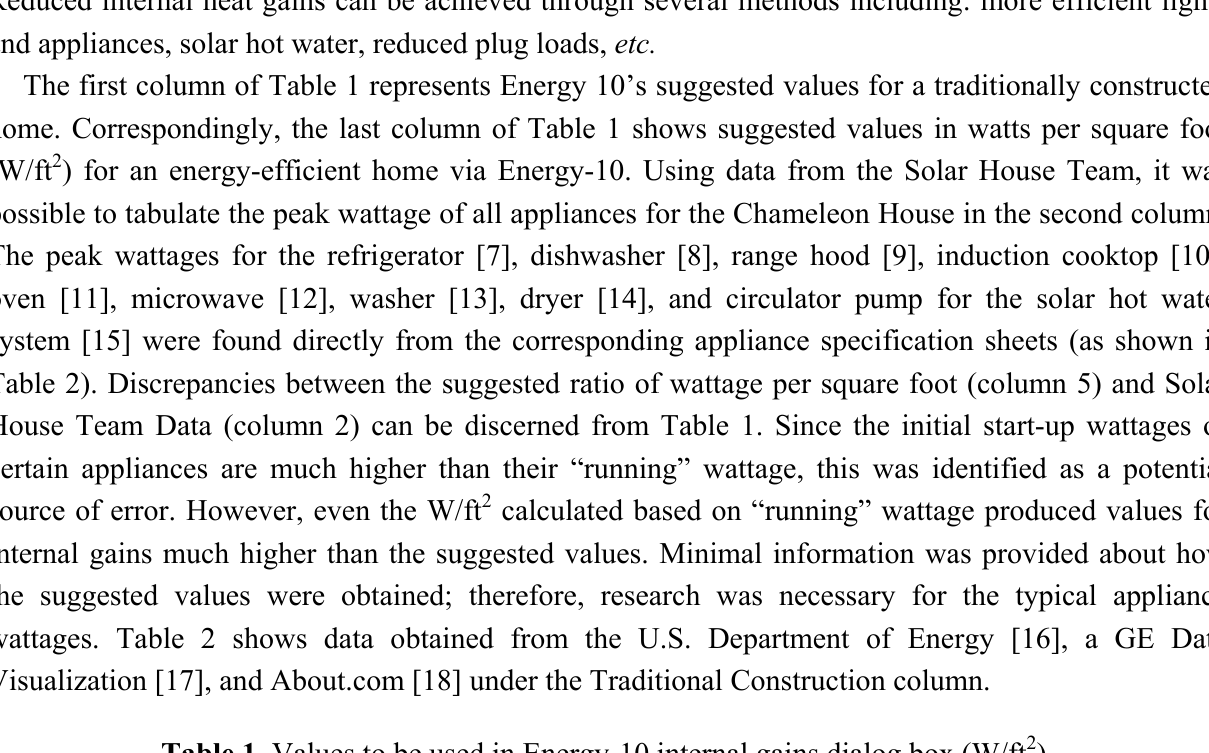
Table 1. Values to be used in Energy-10 internal gains dialog box (W/ft 2